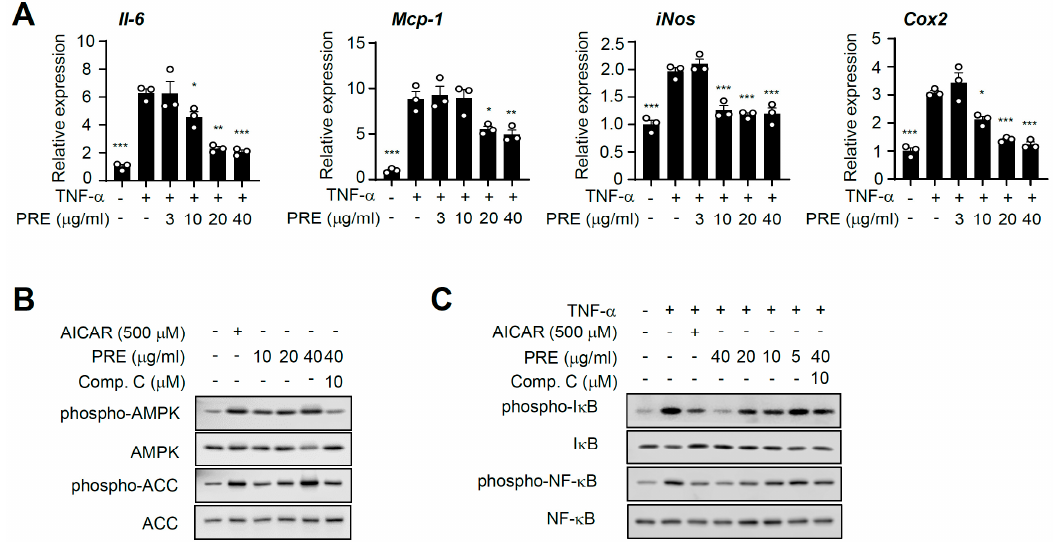
Figure 2. The e ff ects of PRE on TNF- α -induced pro-inflammatory gene expression and AMPK activation in 3T3-L1 adipocytes. ( A ) 3T3-L1 adipocytes were pre-incubated with the indicated concentration of PRE for 24 h, followed by treatment with 20 ng / mL TNF- α for 5 h. Total RNA was isolated, and the mRNA expression level of each gene was analyzed by real time-PCR. Data are shown as the mean ± S.E.M. ( n = 3) * p < 0.05; ** p < 0.001; *** p < 0.0001 compared to the TNF- α -only-treated group. ( B ) After 3T3-L1 adipocytes were pre-incubation with/without compound C for 1 h, cells were treated with PRE or AICAR for an additional 2 h. The expression of phospho-AMPK, AMPK, phospho-ACC, and ACC was analyzed by Western blotting. ( C ) 3T3-L1 adipocytes were pretreated with the indicated concentration of PRE for 24 h and AICAR for 2 h before 20 ng/mL TNF- α treatment for 30 min. Compound C (Comp. C) was pretreated for 1h before PRE treatment. The expression of phospho-I κ B, I κ B, phospho-NF- κ B, NF- κ B, and tubulin was analyzed by Western blotting.